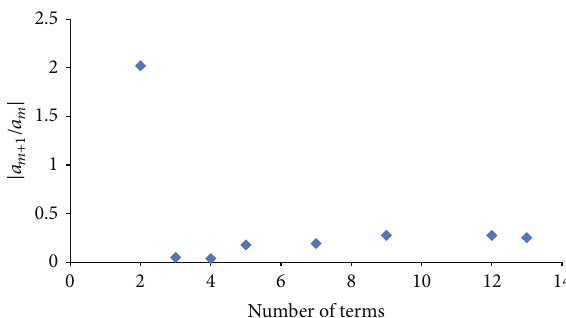
Figure 3: Theratio convergence testapplied to theseries coefficients (MDE) for MDM and HPM as a function of the number of terms in series.